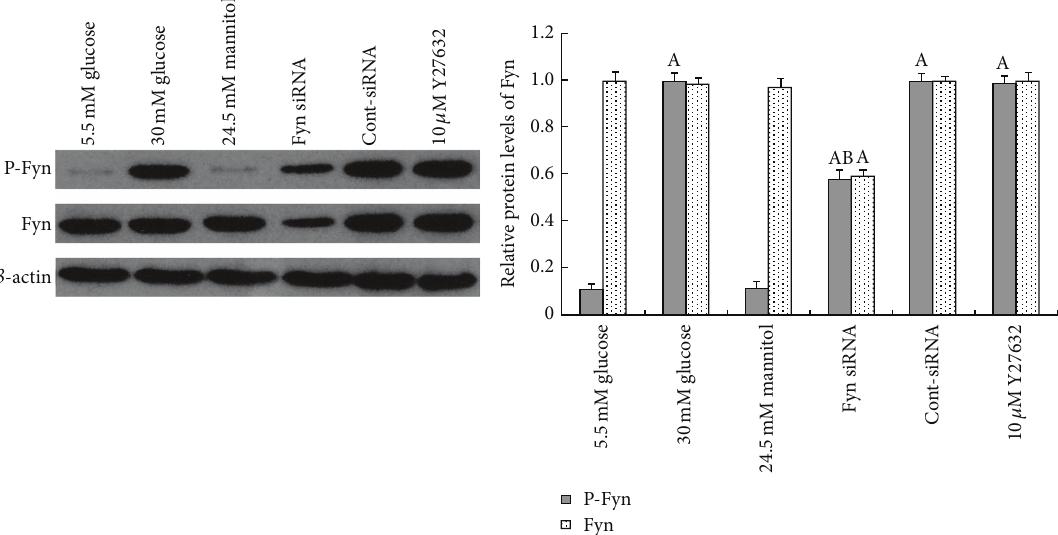
Figure5:WesternblotanalysisofalterationstoFynexpressionandFynactivationinpodocytes.LevelsofactivatedFynexhibitedaremarkable upregulation after 48-hour incubation with 30mM glucose (lane 2) compared with cells incubated with 5.5 mM glucose (lane 1). Fyn siRNA significantly downregulated Fyn expression and activity (lane 4), whereas pretreatment with 10 𝜇 M Y27632 for 30 minutes showed little effects on Fyn activation (lane 5). Control podocytes were treated with 5.5 mM glucose plus 24.5 mM mannitol for 48 hours (lane 3) or transfected with Cont-siRNA (lane 5). Values denote the mean ± SD; A 𝑃 < 0.05 versus 5.5 mM glucose and B 𝑃 < 0.05 versus 30 mM